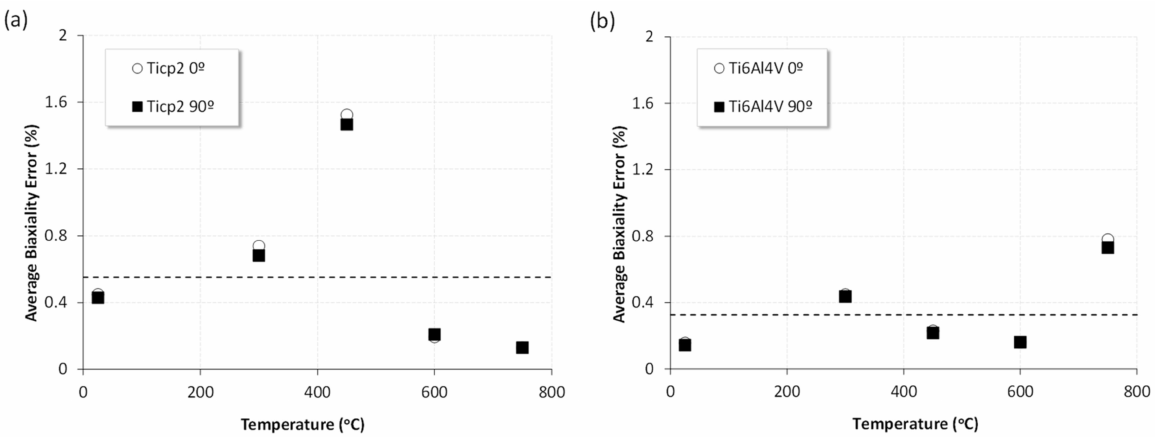
Figure 11. Biaxial influence on the equivalent stress analysis expressed as the value of the average error. ( a ) Ticp2; ( b ) Ti6Al4V.